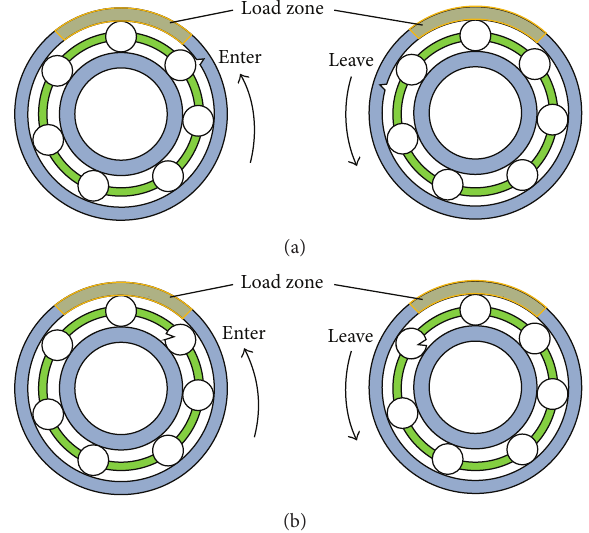
Figure 4: Motion processes of external rotor bearing with defect. (a) Outer race fault and (b) roller